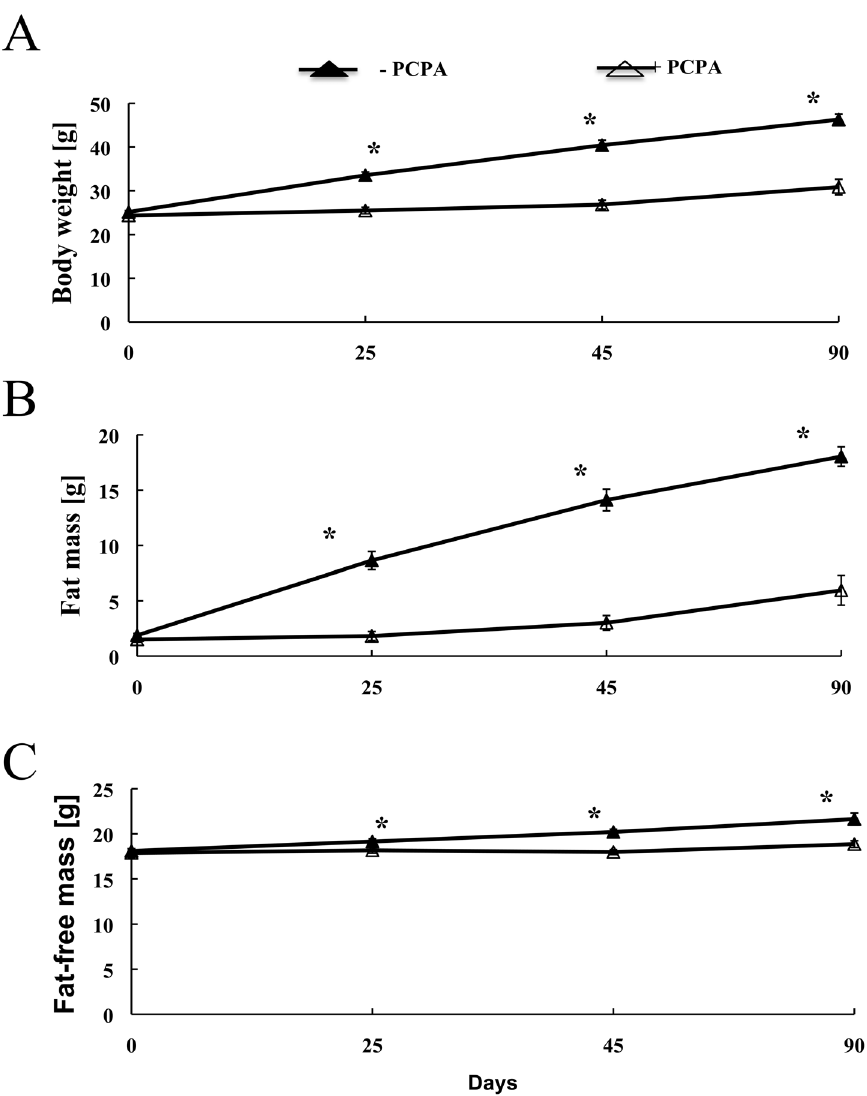
Figure 1. Mice treated with 2-PCPA for 90 days are resistant to obesity. Mice were fed a HFD with or without 2-PCPA for 90 days. Body weight measured with a scale (A), fat mass (B), and lean mass (C) measured using Magnetic Resonance Spectroscopy are shown. Lines represent means 6 standard errors of each group (n=5). (*) indicates a statistically significant difference (p , 0.05) between the 2-PCPA-treated and non-treated